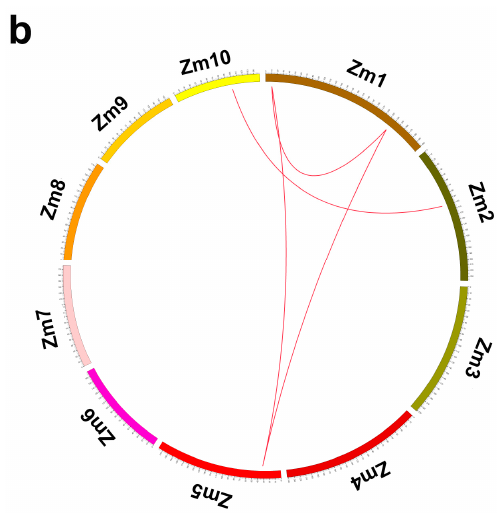
Figure 3. Distribution and synteny of ZmPHT1 genes. ( a ) Distribution of ZmPHT1 genes on the maize chromosomes. On the top of each bar is the chromosome number; ( b ) synteny of ZmPHT1 genes. Zm1–10 represented maize chromosome 1–10, indicated by colored boxes. Chromosome box numbers represent sequence lengths in megabases. All of the syntenic genes were located in the map and linked by red lines.